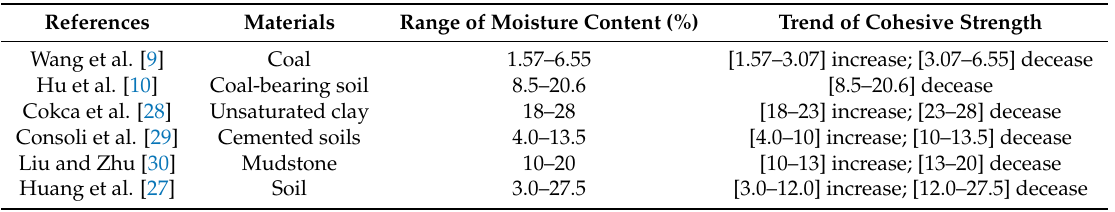
Table 3. References on the effect of moisture content on cohesive